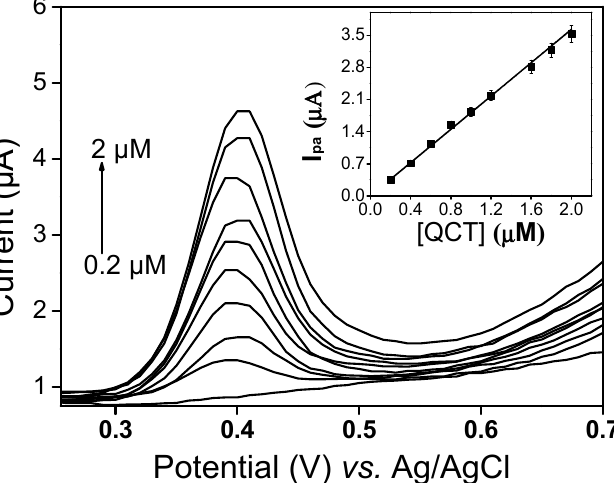
Figure 8. DPV voltammograms of QCT in a LaNH 3 + /GCE sensor at different concentrations (0.0, 0.2, 0.4, 0.6, 0.8, 1.0, 1.2, 1.6, 1.8, 2.0 µM). Inset: Plot of i pa vs. quercetin concentrations (QCT) in a 50:50 (v/v) phosphate buffer and EtOH mixture solution (pH 3).